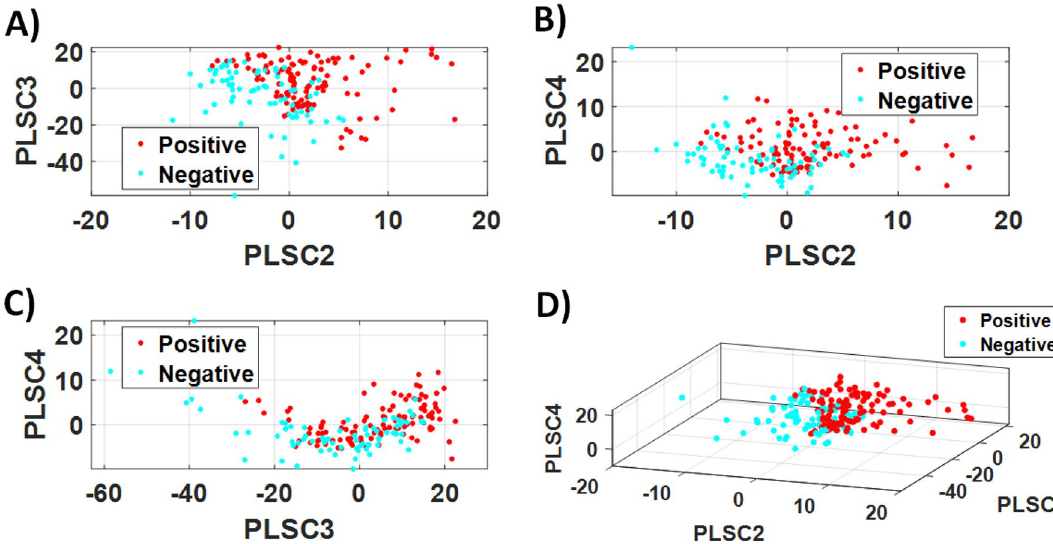
Figure 2. PLS score plots of ( A ) PLSC2 × PLSC3, ( B ) PLSC2 × PLSC4, ( C ) PLSC3 × PLSC4, ( D ) PLSC2 × PLSC3 × PLSC4 for COVID-19 positive and negative groups of the LIQUID 1 dataset. Wavenumber (cm −1 ) Vibrational